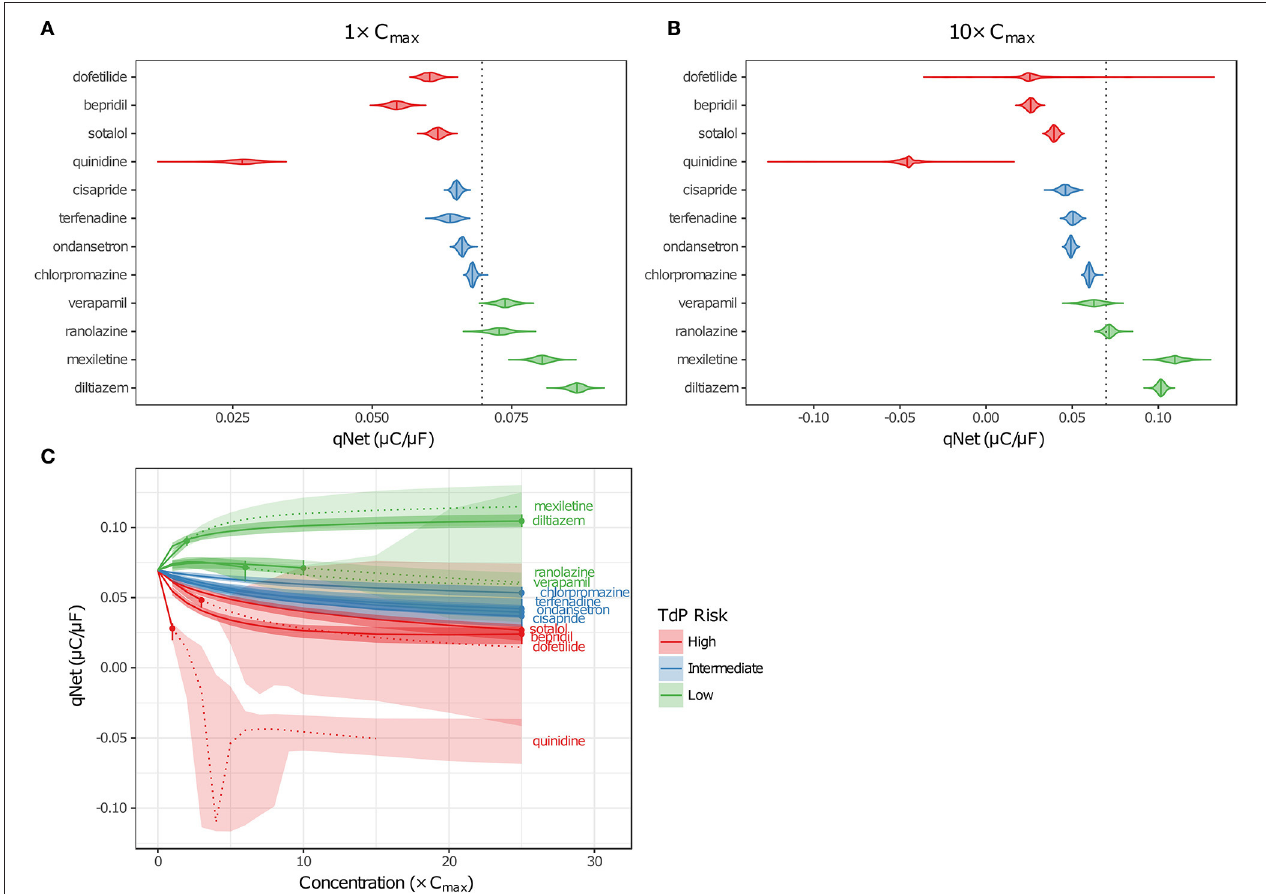
FIGURE 6 | Uncertainty in qNet for the 12 CiPA training drugs. Violin plots are shown for qNet distributions at 1 × (A) and 10 × (B) C max , based on uncertainty-input simulations. Dotted line indicates the control (no drug) value of qNet. (C) qNet at 1 − 10 × C max (1 × increments) and 15 − 25 × C max (5 × increments). Shaded areas indicate the 95% CIs of qNet obtained from uncertainty-input simulations. Points indicate the highest simulated concentration for which complete experimental data on six non-hERG currents were available. Fixed-input results are shown below (solid lines) or above (dotted lines) this concentration. Likewise, uncertainty-input results are indicated below (dark shaded areas) or above (light shaded areas) this concentration. Simulations with depolarization failure ( Figure 5B ) were excluded from the results. For all panels, High TdP-risk drugs are in red, Intermediate-risk drugs are in blue, and Low-risk drugs are in